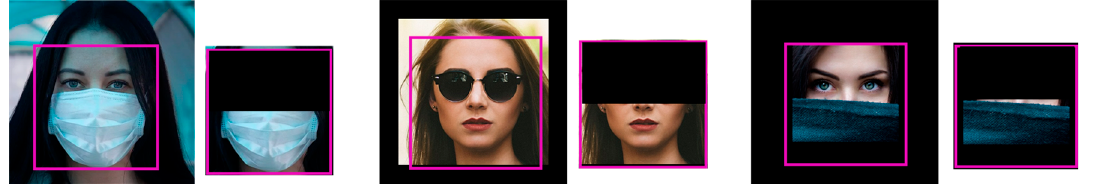
Figure 5. Example of the original image and the picture for occlusion detection.